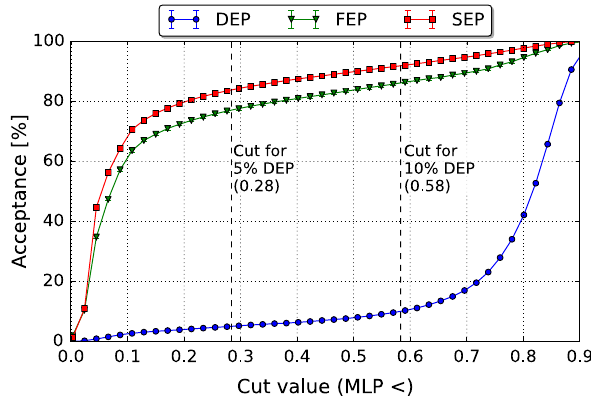
Fig. 8 Acceptance of the DEP (1592 keV), 212 Bi FEP (1620 keV) and SEP (2103 keV) events as a function of the MSE PSA cut (MLP smaller than a given value, DEP/FEP training scenario). Two dashed vertical lines show the cut values for 5 and 10% DEP events acceptance